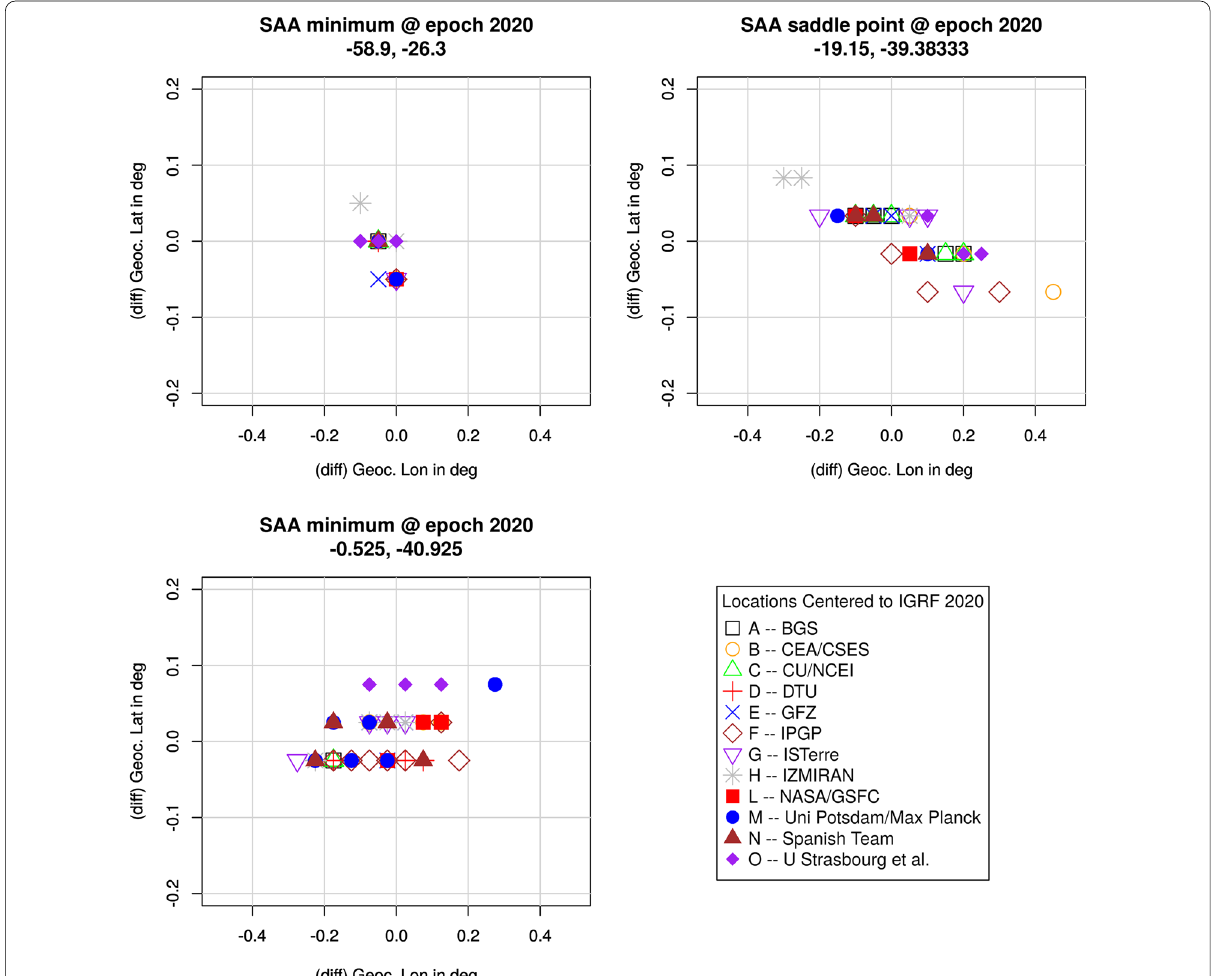
Fig. 8 The locations of SAA main minimum (top left), saddle point (top right) and second minimum (bottom left) for all IGRF candidate models are shown as an indication of the robustness of the results from our Mag.num model (blue cross). Minima and saddle point have been determined from a 0.05 ◦ grid and in some cases the same value is found on two or more grid